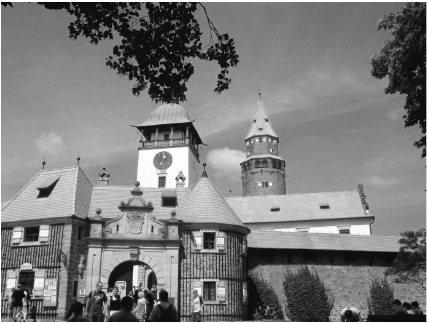
Figure 4: The SA fusion of the image “Castle,” approximate run time: 1,9 sec.